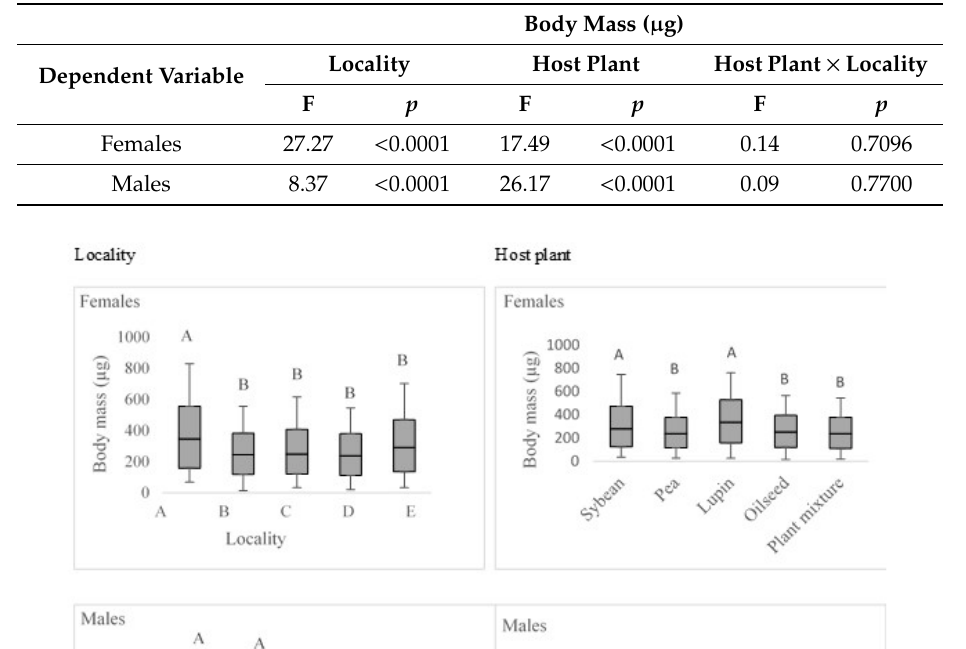
Table 3. Summary table of statistics from body mass using general linear model (GLM).